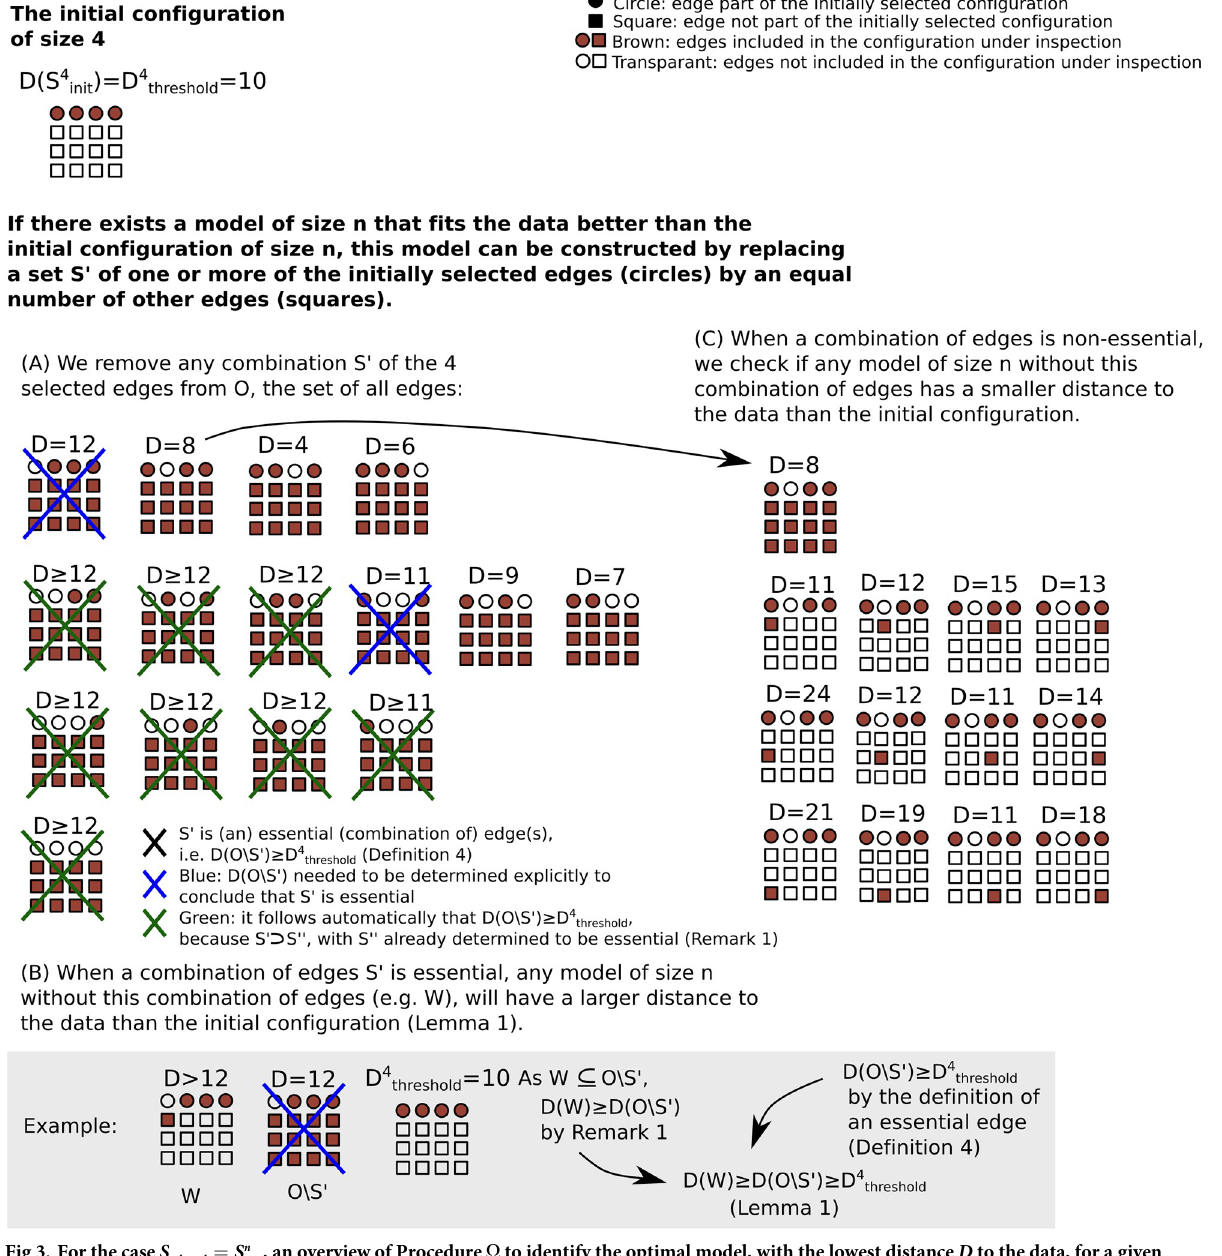
Fig 3. For the case S ¼ S n , an overview of Procedure O to identify the optimal model, with the lowest distance D to the data, for a given selected init model size n out of N statistically significant edges (SSEs). We show an example with initial configuration S 4 of size 4 and 16 SSEs. Circles represent init edges in S 4 and squares represent edges that are not in S 4 . We assume the model with the lowest AIC currently identified is S 4 , i.e. S ¼ S 4 , selected init init init init such that D 4 ¼ D ð S 4 Þ ¼ 10 . We apply Procedure O to determine if a 4-sized model exists with a smaller D than D ð S 4 Þ . If there exists a model W threshold init init ), this model can be constructed by replacing a set S 0 of one or more of of size 4 that fits the data better than the initial configuration (i.e. D ( W ) < D threshold the initially selected edges (circles) by an equal number of other edges (squares). The brown fill colouring indicates edges included and the white fill correspond to edges excluded in the configuration under inspection. (A) We determine which of the 15 possible combinations of the 4 edges that are part of the initial configuration of size 4 are essential. We remove any combination S 0 of the 4 selected edges from O , the set of all SSEs. When , S 0 is essential (Definition 4), which we indicate with a blue or green cross. Blue crosses correspond to configurations O n S 0 for D ð O n S 0 Þ � D 4 threshold which we have to determine the value of D ð O n S 0 Þ explicitly. Green crosses correspond to configurations O n S 0 , where S 0 can be immediately deduced to be essential because S 00 contains an essential subconfiguration S 00 (Lemma 2). To clarify, consider a configuration of fifteen edges, excluding only a single edge from the initially selected model. When this configuration of 15 edges has a worse fit to the data than the initially selected model, removing further edges from this configuration will only reduce the quality of the fit and we thus do not have to determine their fit to the data explicitly